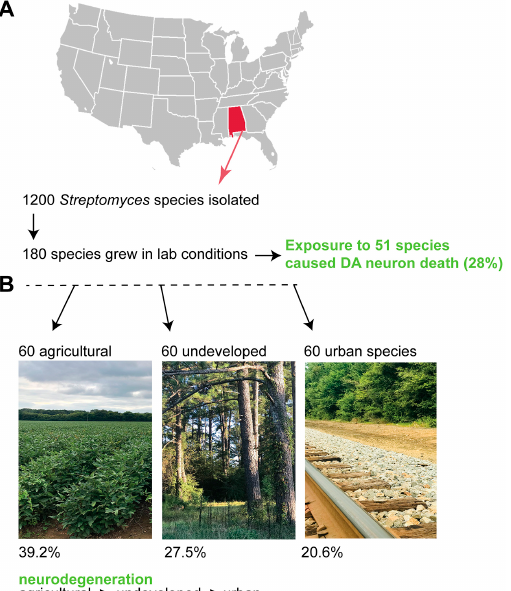
Figure 5. Streptomyces isolates from the environment cause DA neuron death in C. elegans . ( A ) We isolated